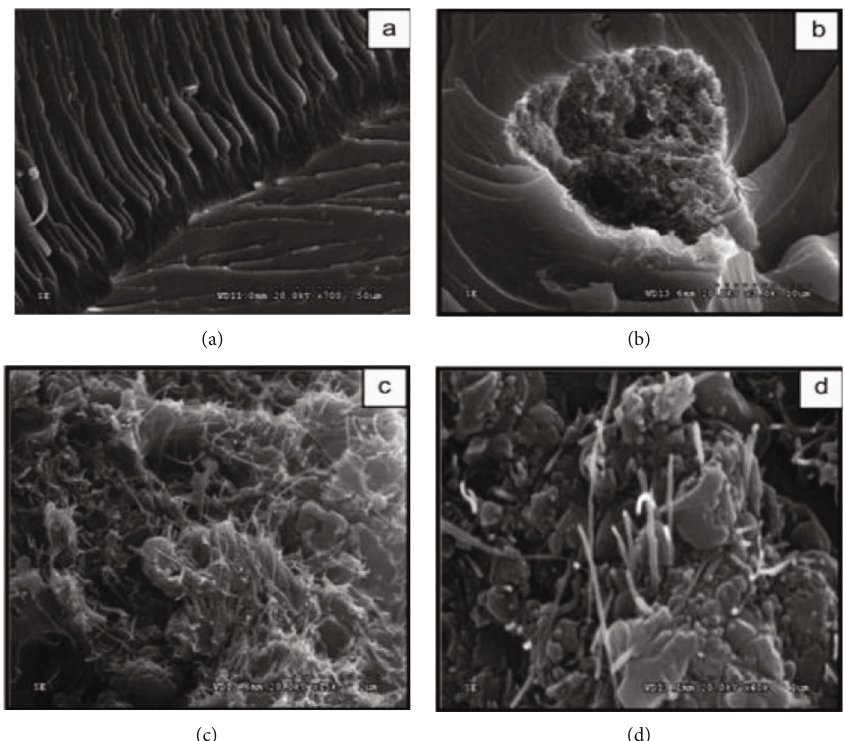
Figure 1: Fracture surface of (a, b) agglomerated CNTs within the epoxy and (c-d) functionalized CNT/epoxy composite containing 1 wt.% functionalized CNTs [8].